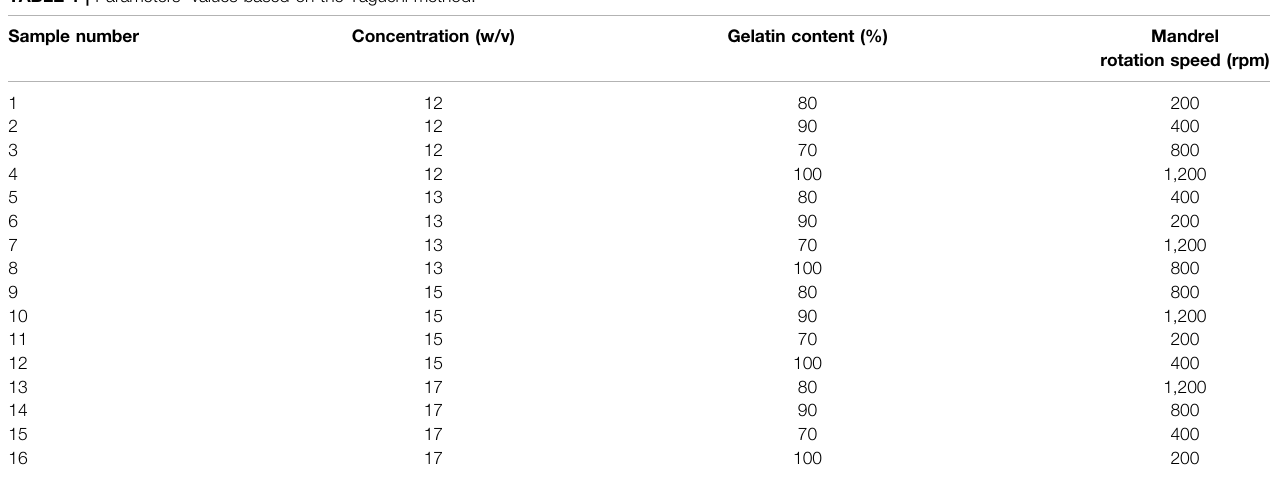
TABLE 1 | Parameters ’ values based on the Taguchi